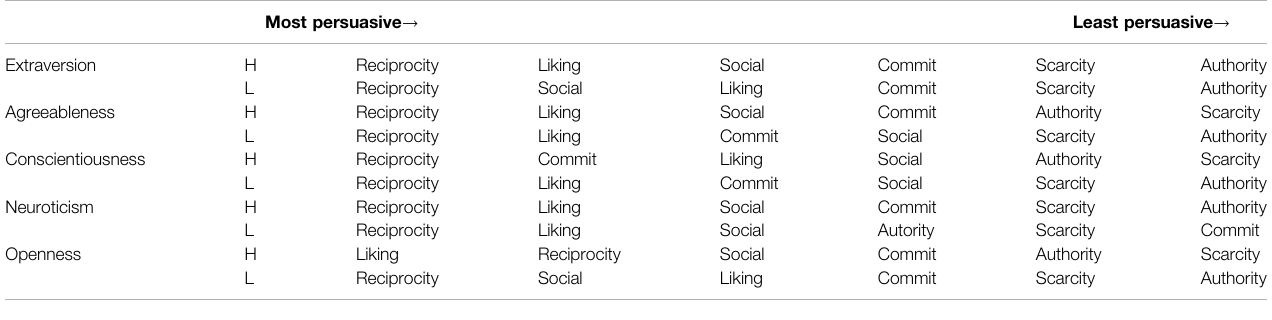
TABLE 7 | Persuasion pro fi les based on personality traits (H: high, L: